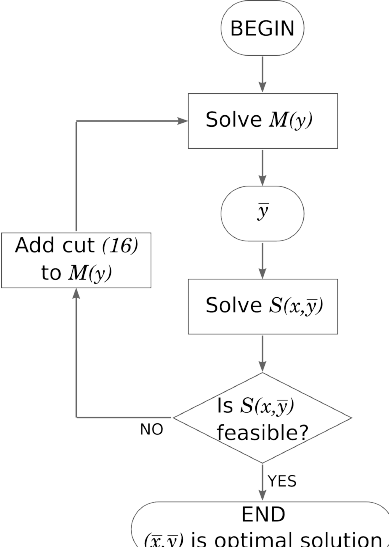
Figure 2. Flow chart of Benders’ decomposition-based